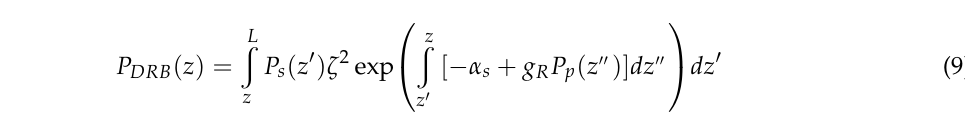
Figure 7. OSNR vs. distance, with only spontaneous Raman scattering (spRs) and with both spRs and DRB. Next, we take the NSNI into consideration. According the analysis above, when the receiver- side DBP is applied, the noise in the near-receiver section causes more severe NSNI, because the noise in the near-receiver section is amplified in the DBP process. Thus, the NSNI caused by spontaneous Raman scattering is also higher than the NSNI caused by the DRB. To demonstrate this point, the SNRs of the signals were calculated using the proposed theoretical model with the DRB included, and the results were compared with the case in which only spontaneous Raman scattering was considered, as shown in Figure 8. From Figure 8, we can see that when the DRB was considered, the proposed model had good accuracy. When the pre-compensation length was less than 60 km, the two curves were almost coincident. With the pre-compensation length increasing over 60 km, a difference appeared and the SNR of the signal including DRB was lower than the SNR of the signal without